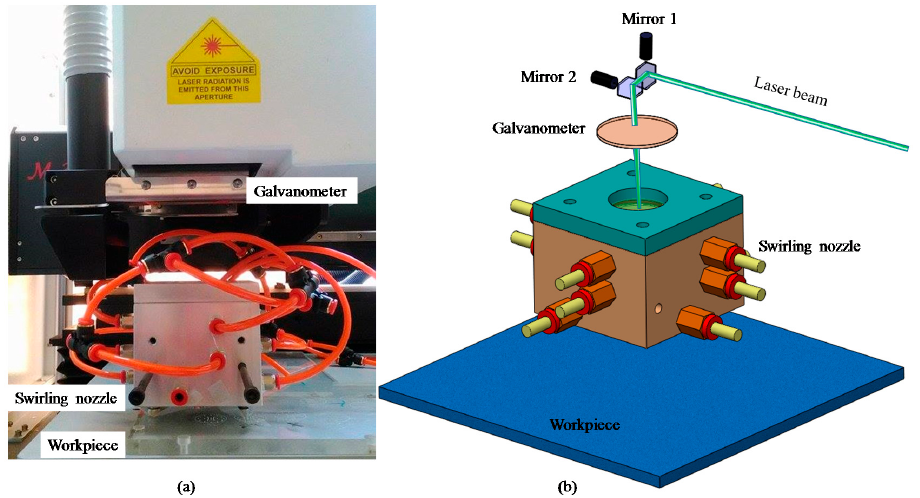
Figure 10. ( a ) Experimental setup for assisted swirling nozzle for CO 2 laser; ( b ) laser trepanning schematic layout.